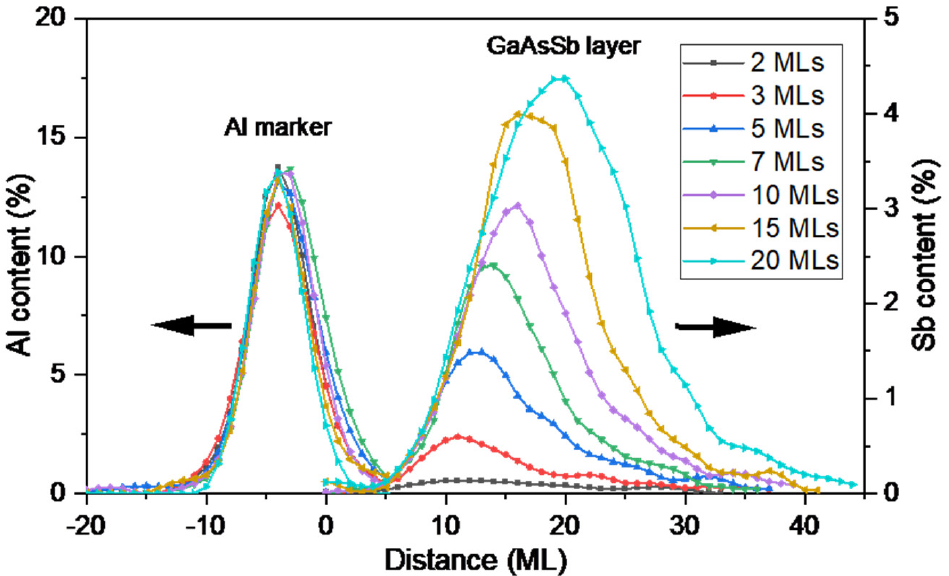
Figure 4. Superposed profiles of Sb and Al content along the growth direction for each period obtained from the high-magnification EDX maps.